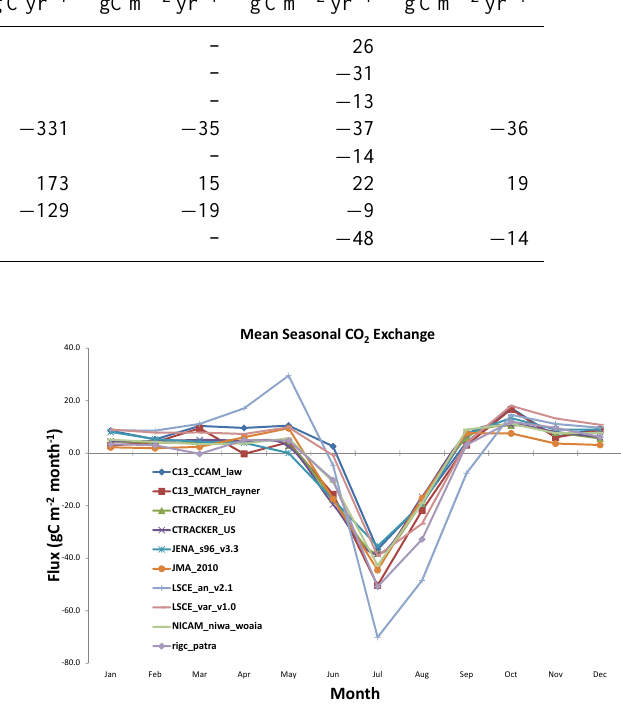
Table 9. Mean annual net CO 2 -C exchange estimates of inversion models of Arctic tundra for the time periods 1990–1999 and 2000–2006. Model